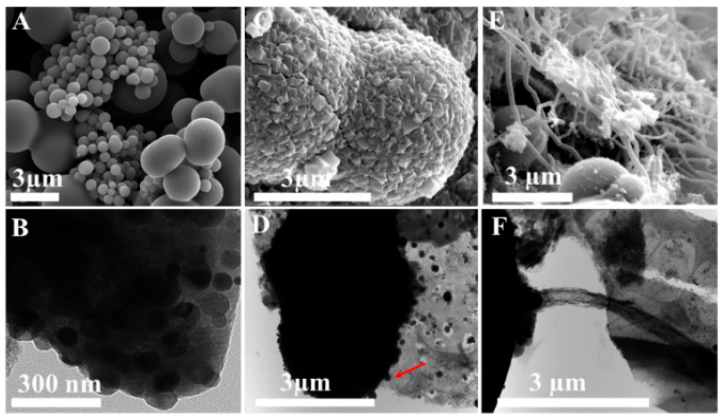
Figure 1. ( A ) SEM image of GAL-Fe-HT prepared using the hydrothermal process combining galactose and FeMNPCs; ( B ) TEM image confirming interior spheres were embedded with FeMNPs; ( C ) SEM image of GAL-Fe-HT pyrolysed at 650 ◦ C with melamine; ( D ) TEM image of diffusion of FeMNPs from the sphere pyrolysed at 950 ◦ C with melamine (red arrow FeMNPC); ( E ) SEM image of final composite material (GAL-Fe-N) with integrated N-doped carbon microspheres and N-CNT; and ( F ) TEM image of CNT forming from the FeMNPC within the sphere.